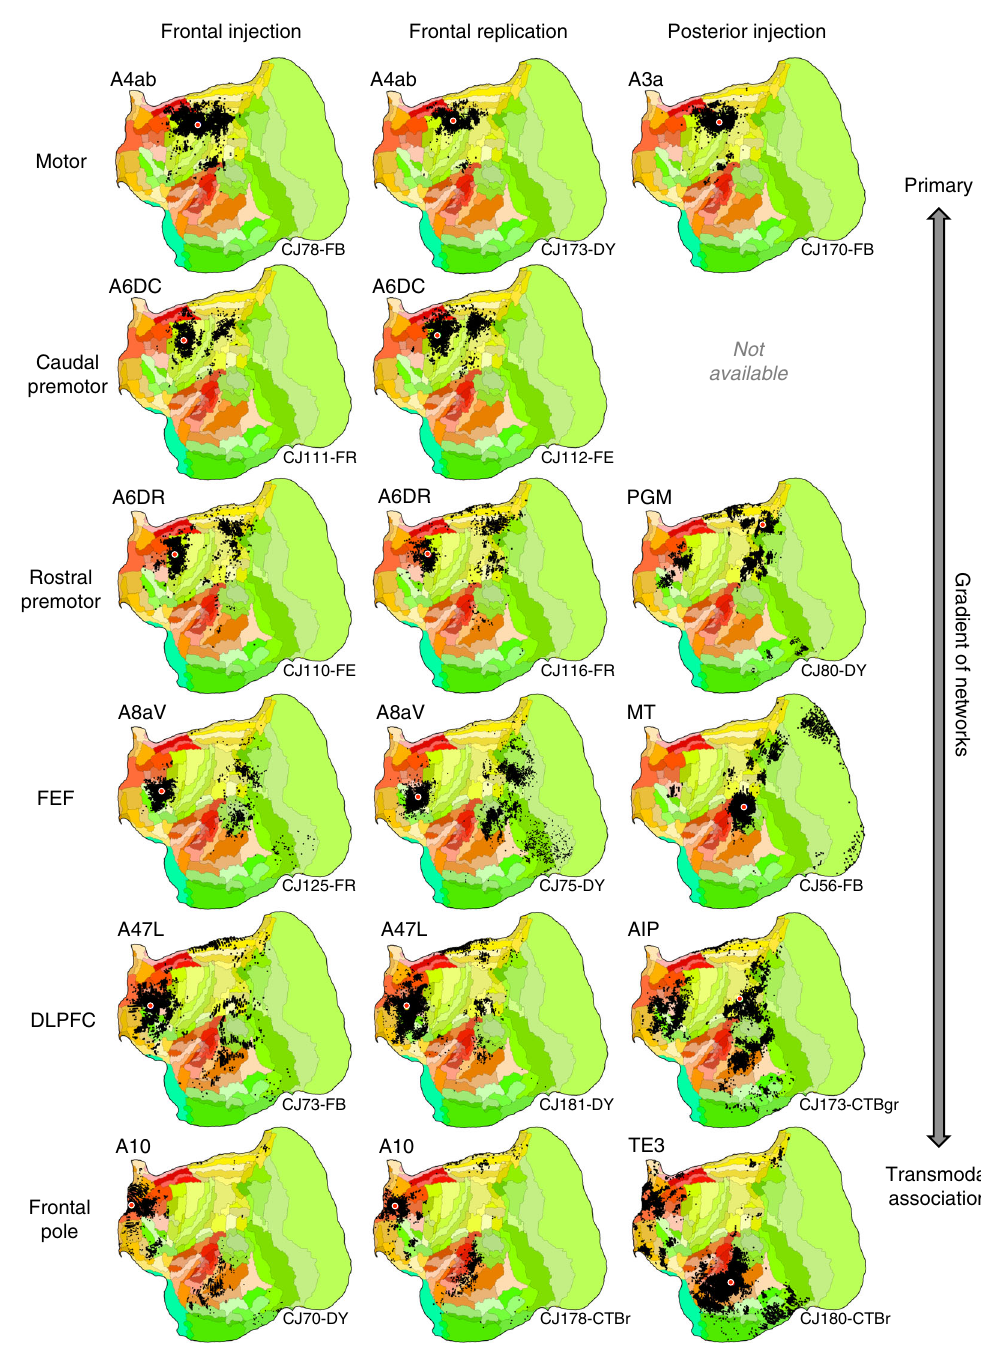
Fig. 2 Aggregate analysis of anatomical connectivity reveals a macroscale organization of networks. Each row displays a candidate network that is based on a frontal injection (left column), replication of the frontal injection (middle column), and corroboration of the network using a posterior injection (right column). Flat map format from Fig. 1. These displayed networks represent a partial subset of possible networks that could be plotted and do not re fl ect the full complexity of the projection patterns. Nonetheless, they reveal a sequence by which progressively more distributed networks populate the cortex as one goes from primary motor cortex (A4ab) through to frontopolar A10. In each map, the tracer injection is shown with a red dot (all retrograde). Injection cases are labeled in the bottom right as annotated in the Marmoset Brain Architecture Project border of the zones linked to the apex transmodal network. The rostral TE3 injection is fully within the region of frontopolar projections, while the caudal TPO injections are on the border. Of further note is the global observation that the gradient of temporal lobe projections to frontal cortex does not respect the areal boundaries. The projection gradient goes through caudal TPO and rostral TE3, sparing large portions of the two areas.